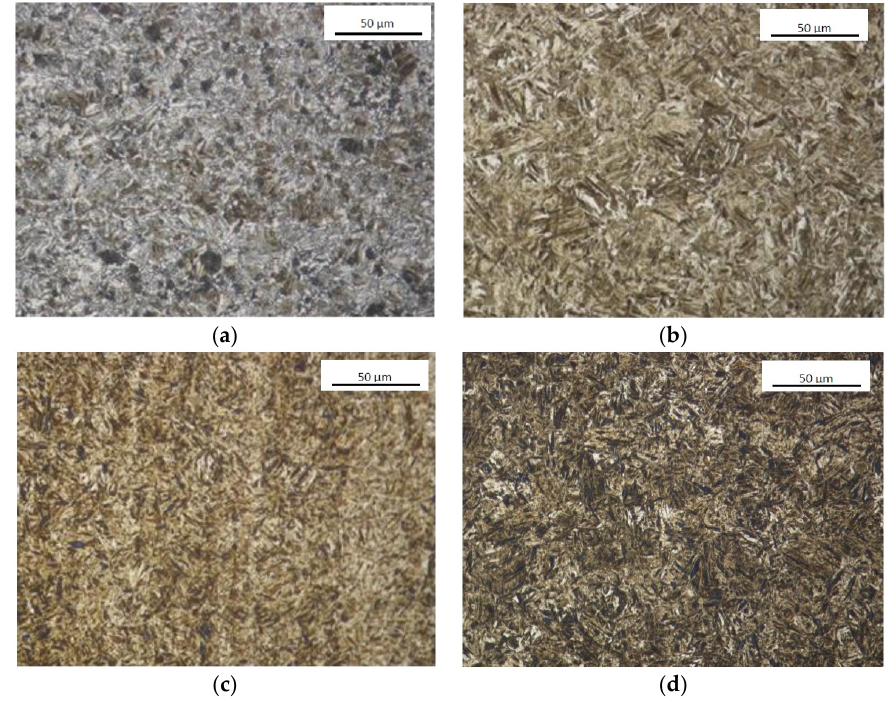
Figure 1. Microstructures of the tested materials. ( a ) B27, ( b ) Hardox 500, ( c ) XAR 600, ( d ) TBL